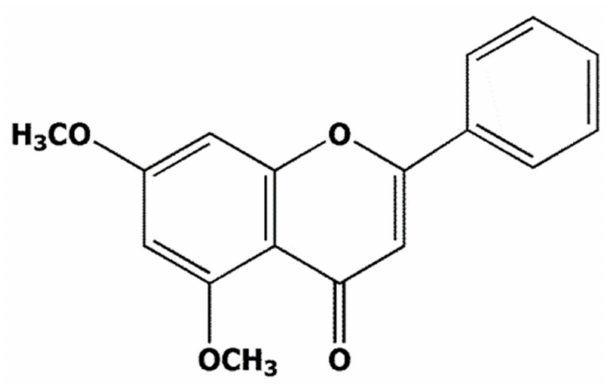
Figure 1. Chemical structure of 5,7-dimethoxyflavone